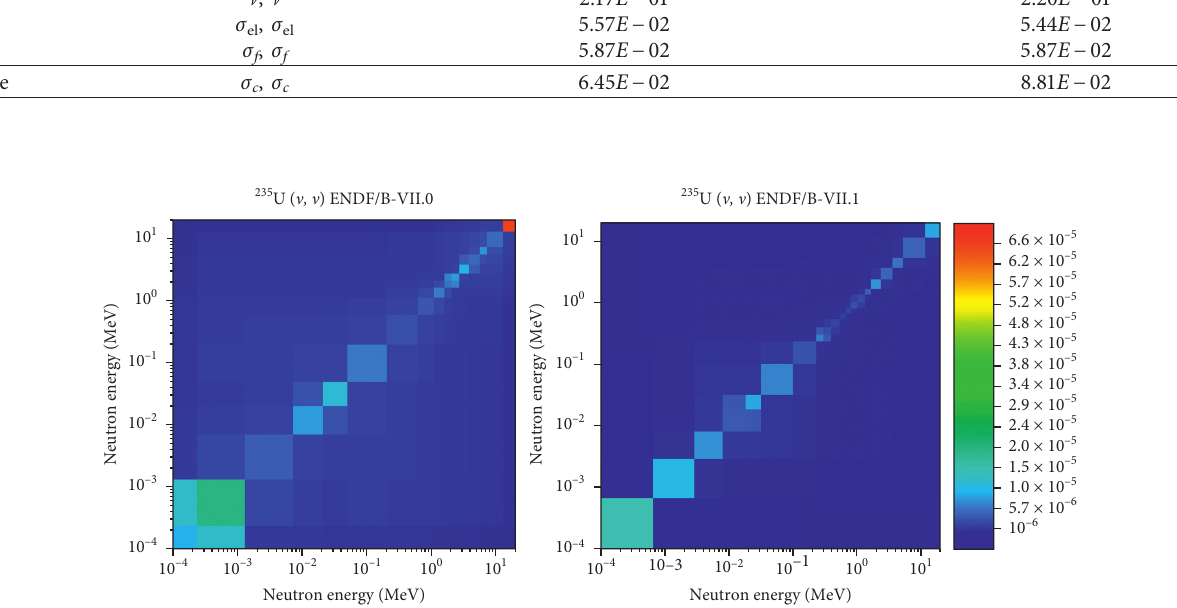
Figure 23: 235 U ( ] , ] ) 44-g and 55-g covariance matrices.